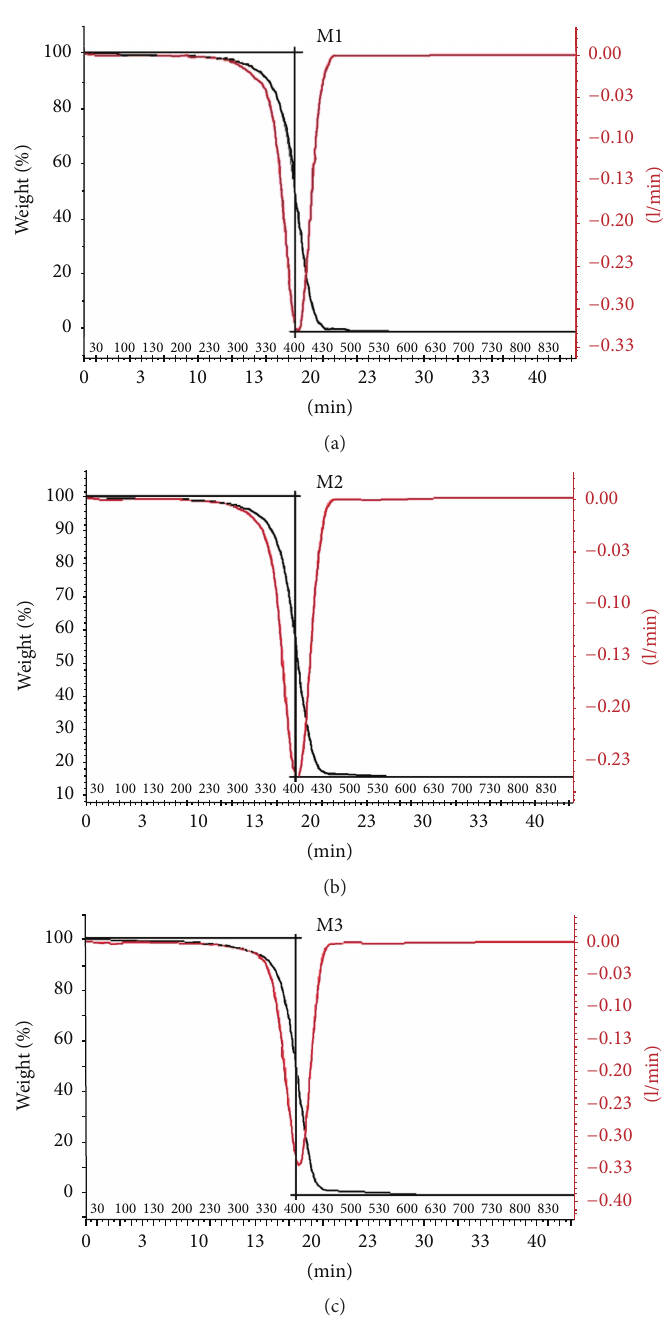
Figure 4: The TGA thermogram of terpolymers M1, M2, and